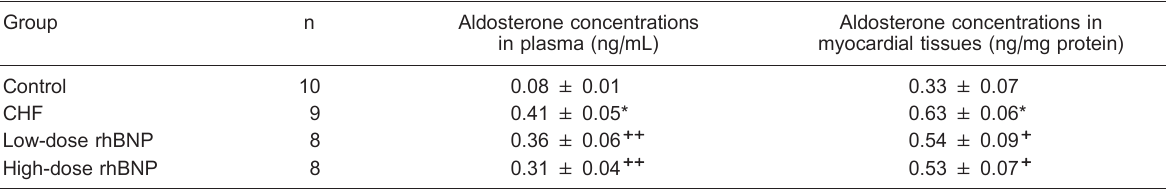
Table 3. Aldosterone concentrations in plasma and myocardial tissues.